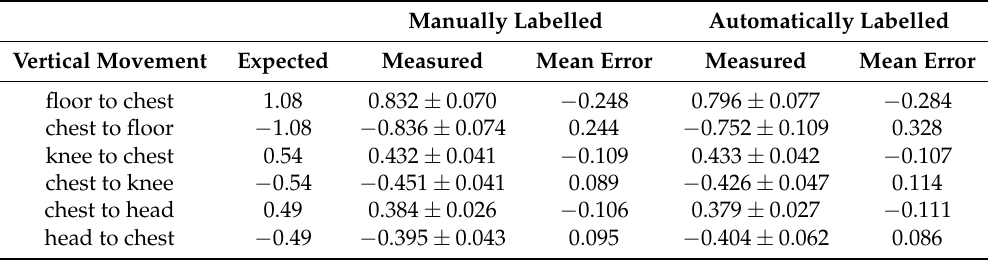
Table 6. The vertical displacement estimates and errors for each lift type. The vertical displacement error is calculated as v est − v actual , where v est is the estimated vertical displacement and v actual is the actual vertical displacement. Distances are displayed in